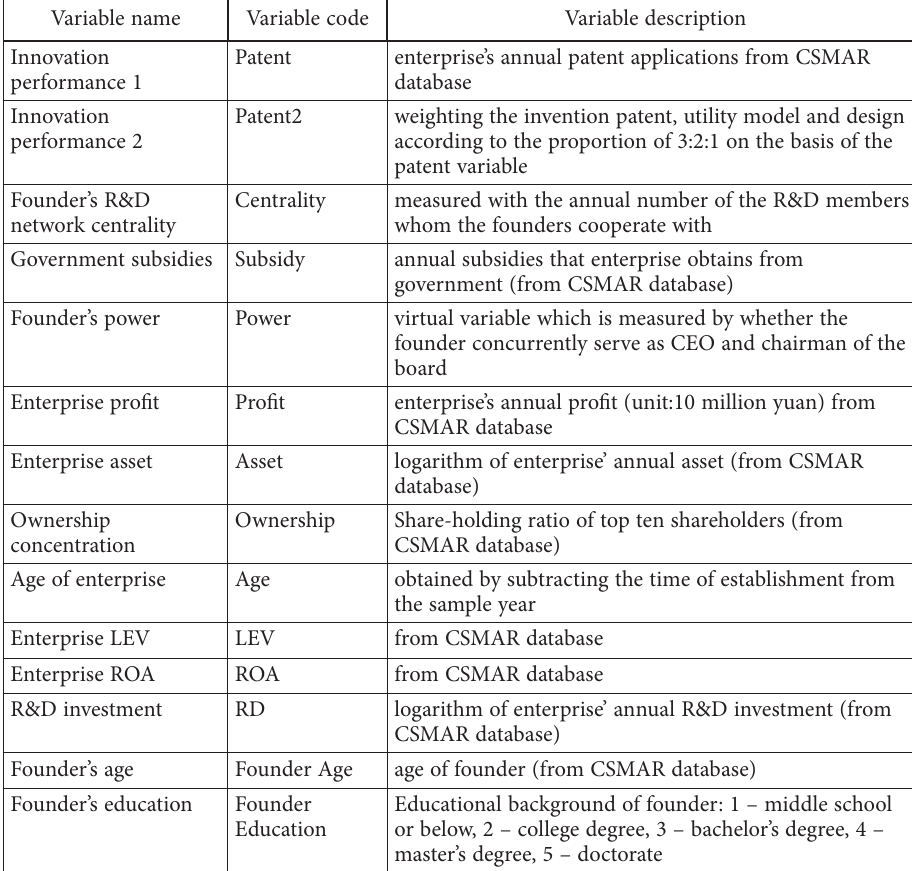
Table 1. Definitions of